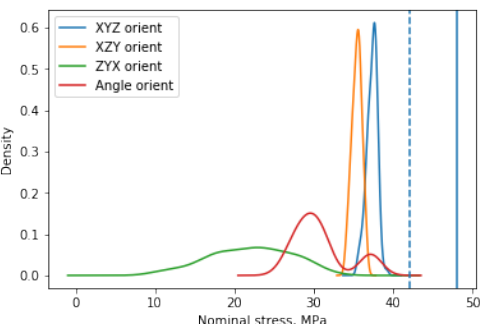
Figure 5. Distribution of nominal stress for different orientations based on kernel distribution estimation. The straight solid (48 MPa for the XYZ orientation) and dashed lines (42 MPa for the ZYX orientation) correspond to the values from the EOS Balanced datasheet.